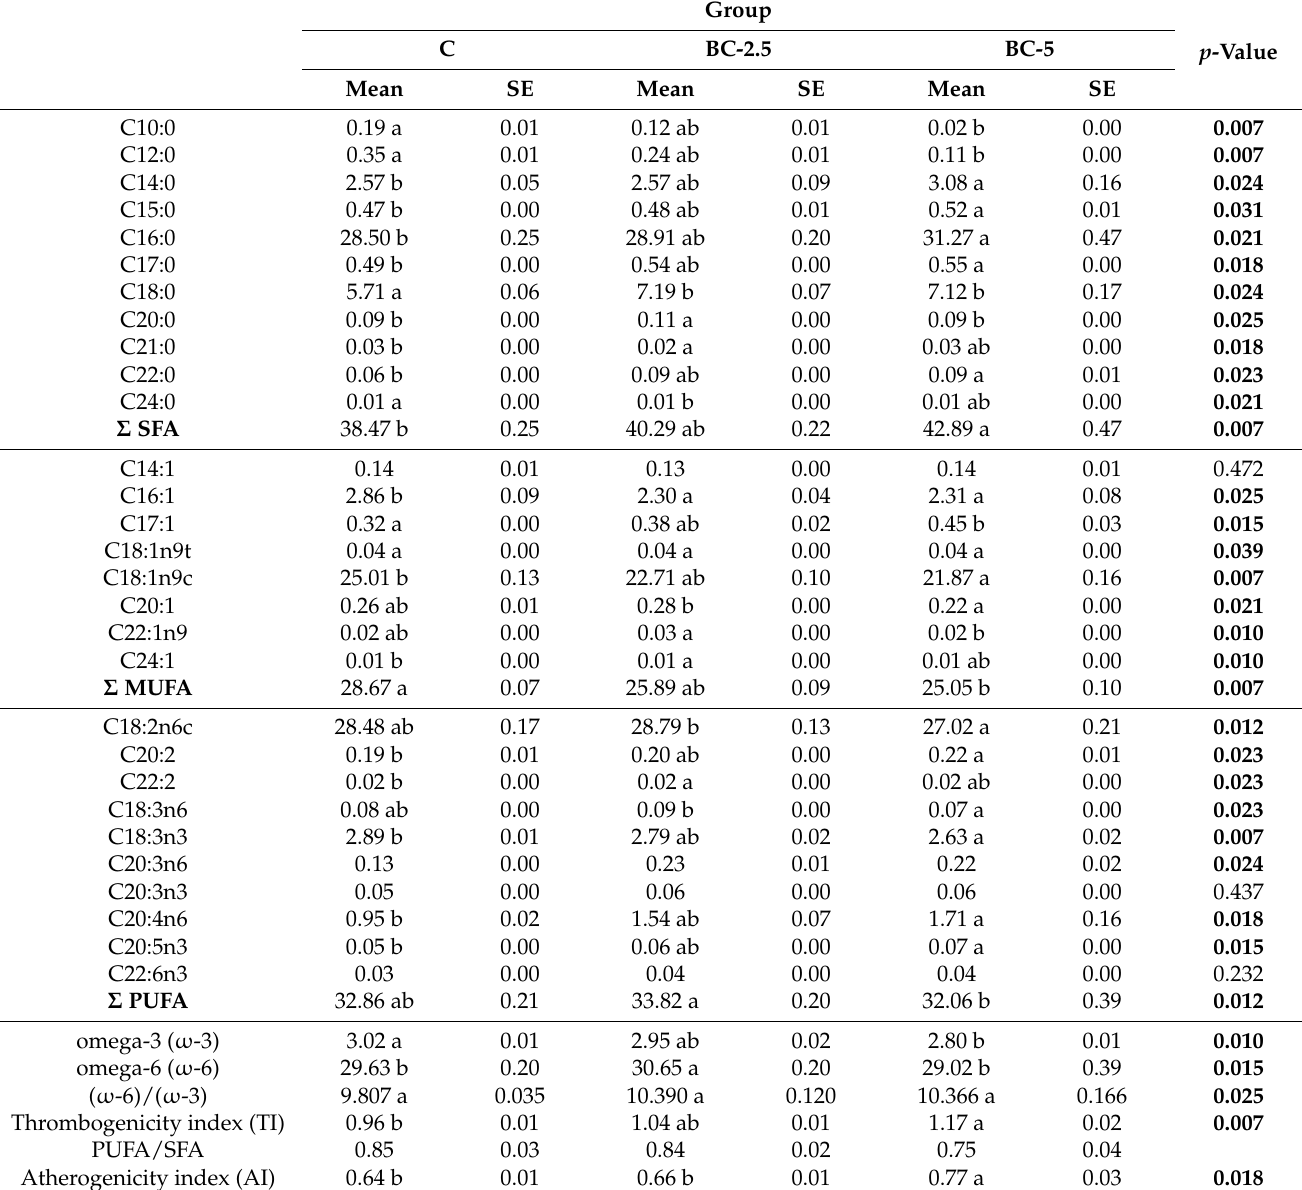
Table 3. Effect of colostrum inclusion in the diet of rabbits on the fatty-acid profile of the meat (mean ± standard error; SE). C = control diet; BC-2.5 = diet supplemented with 2.5% bovine colostrum; BC-5 = diet supplemented with 5% bovine